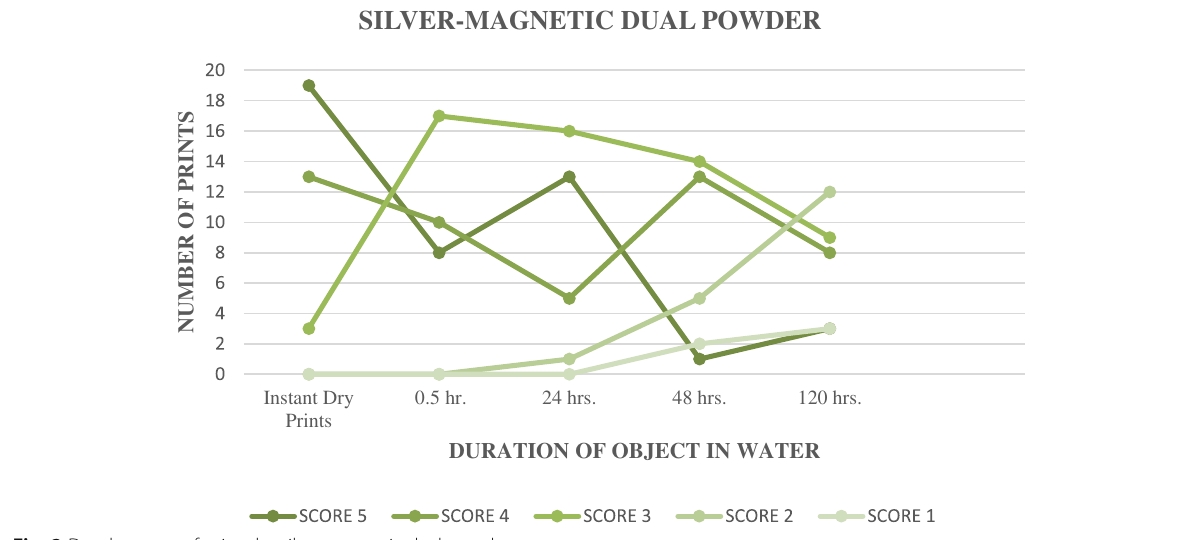
Fig. 2 Development of prints by silver magnetic dual